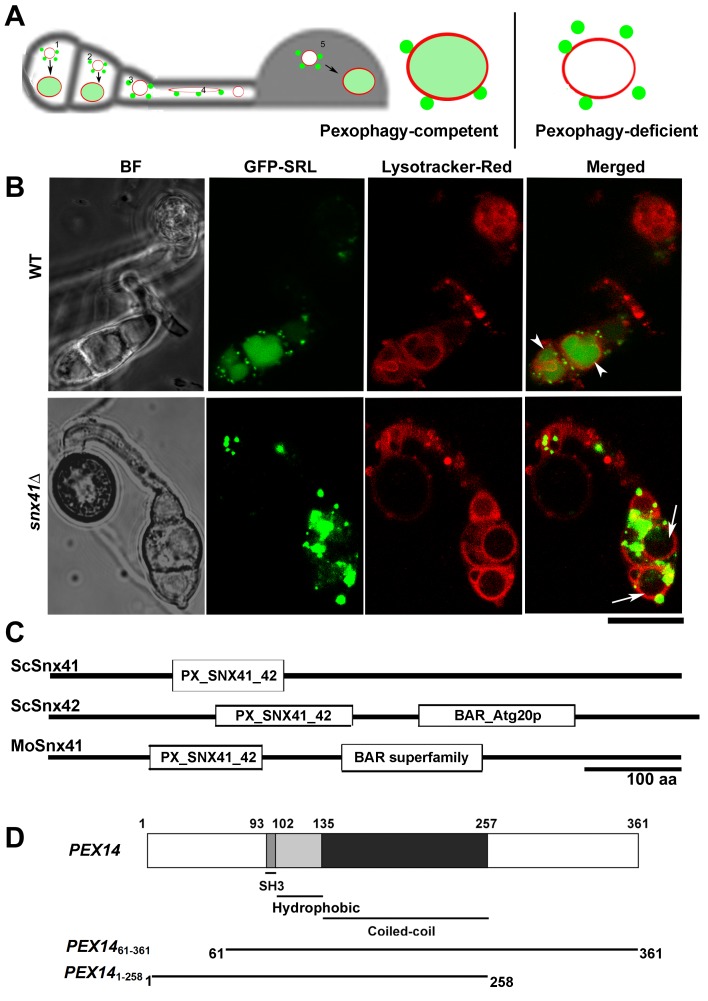
Generation of pexophagy-deficient mutants in M. oryzae
(A) Schematic illustration of pexophagy occurring during conidial germination and appressorial development in M. oryzae. Vacuolar accumulation of GFP-SRL (peroxisome) was first seen in the two non-germinating cells (1 and 2) of the conidium at the early stage, whereas peroxisomes were outside the vacuoles in the germinating cell (3) and in the germ tube (4). In the newly formed appressorium (5), pexophagy was absent as peroxisomes were not delivered into the vacuoles. In mature appressoria, pexophagy occurs again and most of the peroxisomes were delivered to the lumen of the vacuoles. Right panel depicts pexophagy-competent (WT) or pexophagy-deficient situation in such cell types. Red spherical or filamentous compartments, vacuoles (stained by DND99 Lysotracker-Red); green vesicles, peroxisome labeled with GFP-SRL. (B) Pexophagy-competence and pexophagy-deficiency as illustrated by WT and snx41Δ mutant, respectively. Conidia were inoculated on plastic cover slip for 6-8 h, and co-stained with Lysotracker Red DND99 to label the vacuolar compartments 5 min before confocal microscopy. Arrowheads denote vacuolar GFP-SRL signal, an indication of delivery of peroxisomes to the vacuoles for pexophagy. Arrows denote vacuoles lacking GFP-SRL signal, due to blocked pexophagy. Scale bar equals 10 micron. (C) Comparison of amino sequence and domains between ScSnx41, ScSnx42 and MoSnx41. Sequence alignment and domain prediction were performed by using the BLAST program on NCBI website (http://blast.ncbi.nlm.nih.gov/Blast.cgi?PROGRAM=blastp&BLAST_PROGRAMS=blastp&PAGE_TYPE=BlastSearch&SHOW_DEFAULTS=on&LINK_LOC=blasthome). (D) Schematic drawing of the annotated domains within M. oryzae Pex14 polypeptide showing an SH3 domain, a hydrophobic loop and a coiled-coil domain. Precise mutant derivatives for Pex14 are depicted together with the coordinates representing amino acid residues.